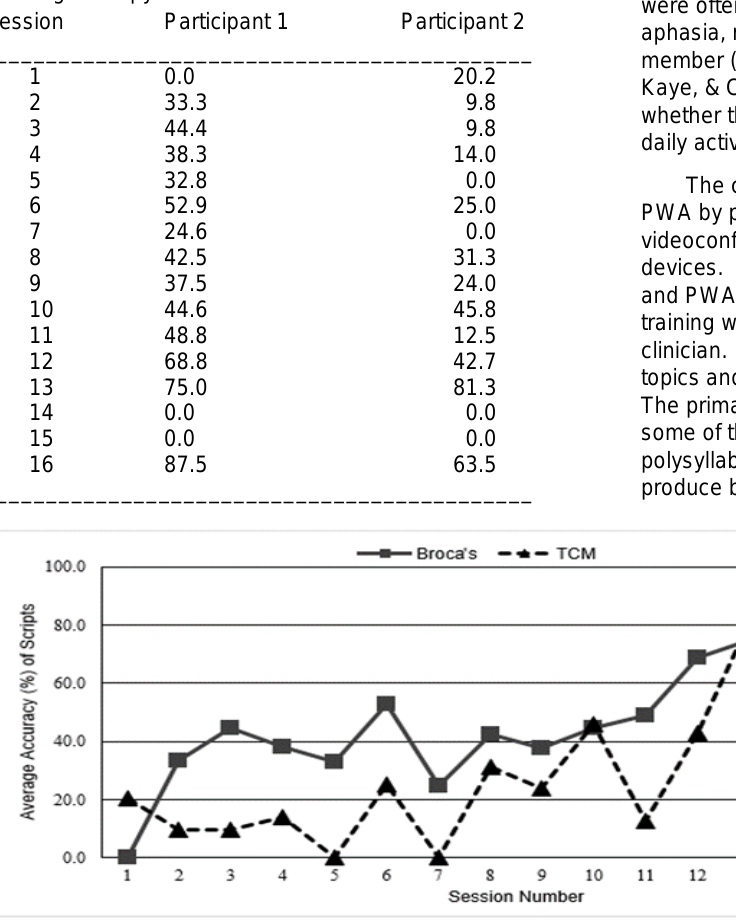
Figure 1. Average percent accuracy of baseline data collected during 13 sessions of script training therapy. Average accuracy (%) of scripts per session as measured in words correct out of words total. Baseline data for Participant 1 with Broca’s aphasia and Participant 2 with Transcortical Motor aphasia are presented for each session. No script training was delivered for two weeks, sessions 13-16. The baseline data for session 13 were collected at the beginning of session. Final data were collected at the end of session